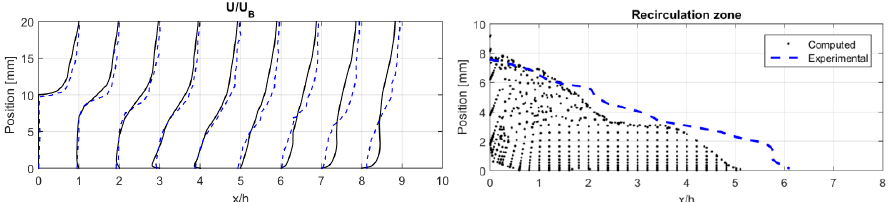
Figure 5. Velocity profiles ( left ) and recirculation zone ( right ) for the best ODF model setting. Experimental results from Claesson (2012) [24] are marked (--).